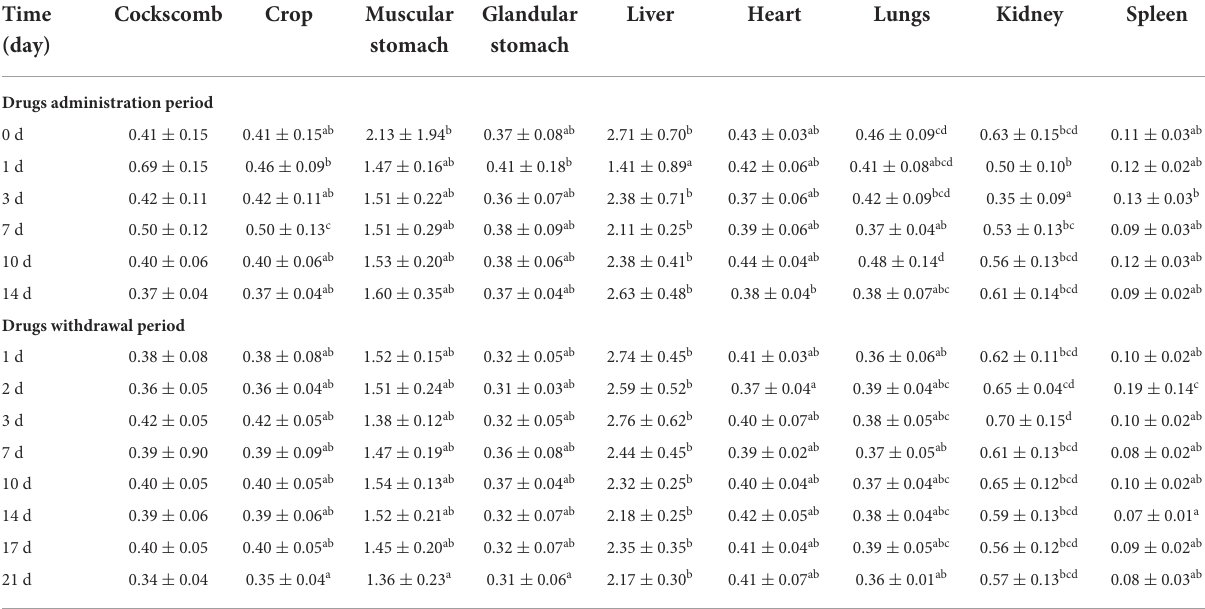
TABLE 1 Effects of deltamethrin on relative organ weight in laying chickens. Time Cockscomb Crop Muscular (day)